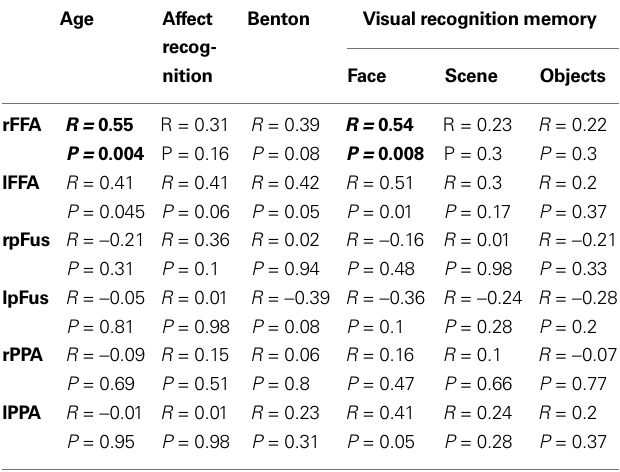
Table 2 | Correlations between ROI volumes, subject’s age and behavioral measures of visual processing. Right and left hemisphere are indicated by (r) and left (l) respectively. Face selective fusiform face area (FFA), object selective pFus/OTS region (pFus), parahippocampal place area (PPA). Bold entries indicate signifi cant correlation after Bonferonni correction for multiple